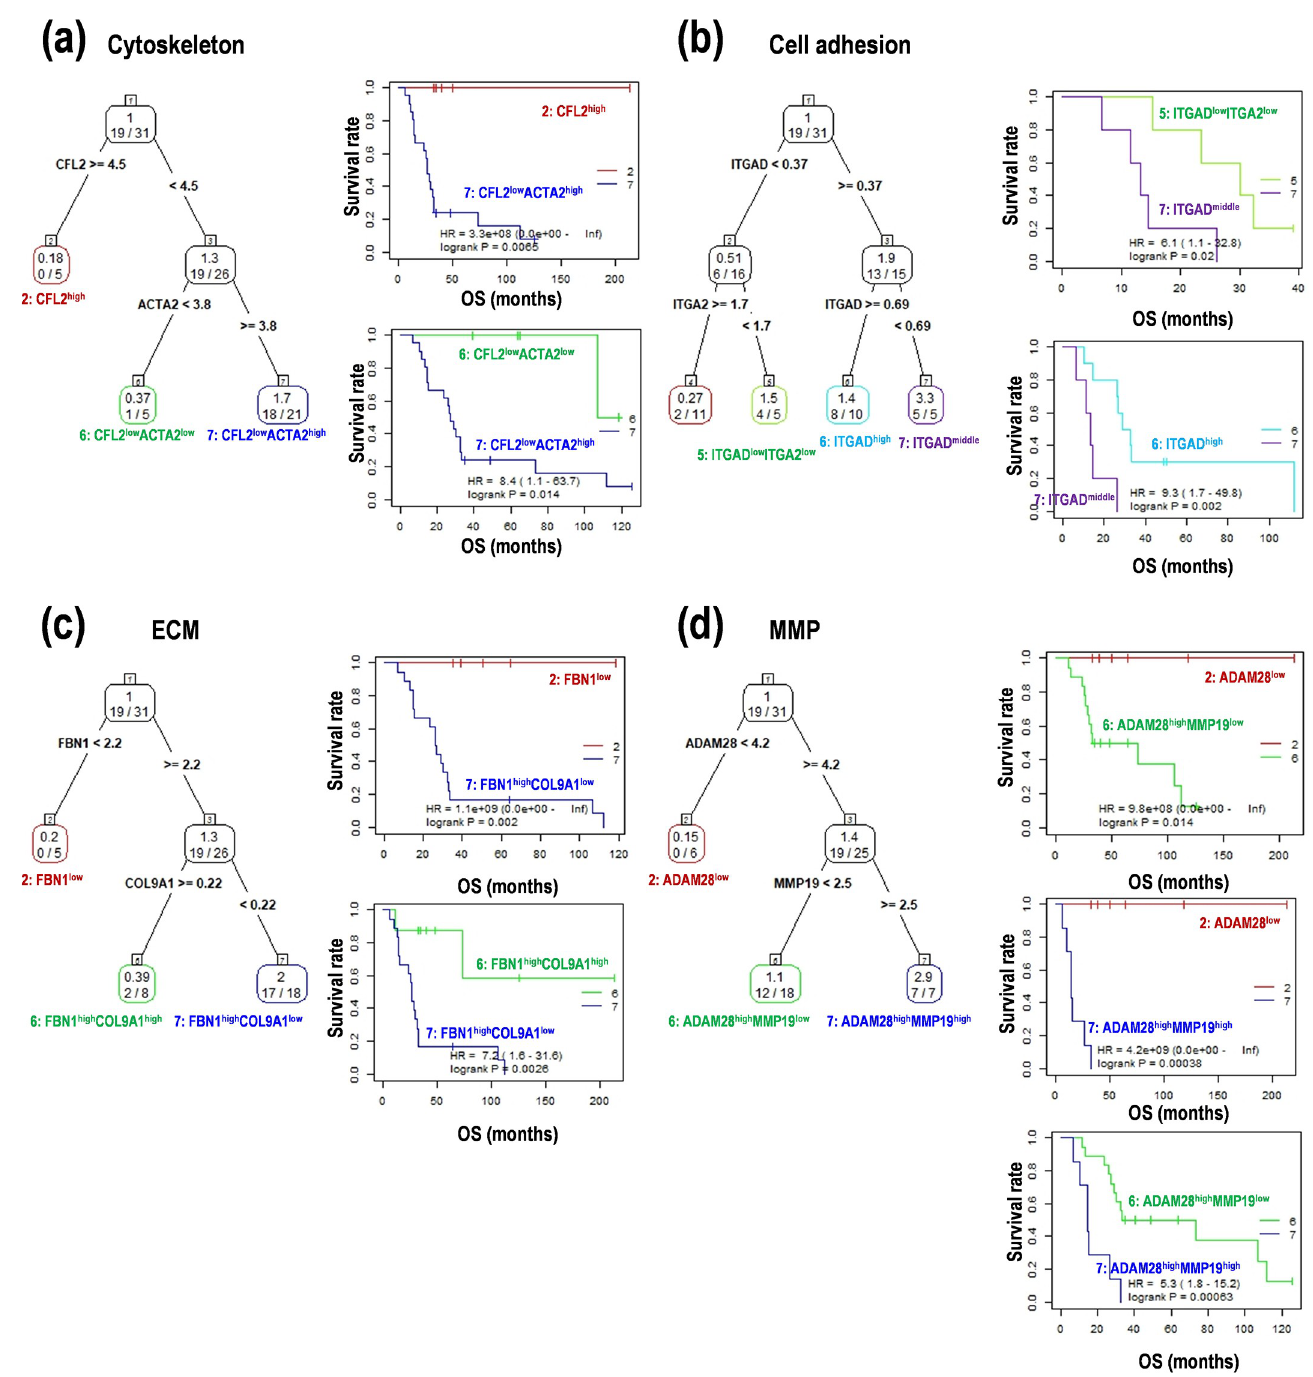
Fig 3. Survival regression tree model for the genes related to cancer morphology and microenvironment in PCNSL. ( a ) CFL2 and ACTA2 in cytoskeleton. ( b ) ITGAD and ITGA2 in cell adhesion. ( c ) FBN1 and COL9A1 in extracellular matrix (ECM). ( d ) ADAM28 and MMP19 in matrix metalloprotease (MMP). Representative tree models and Kaplan-Meier curves are presented. HR; hazard ratio, OS; overall survival.